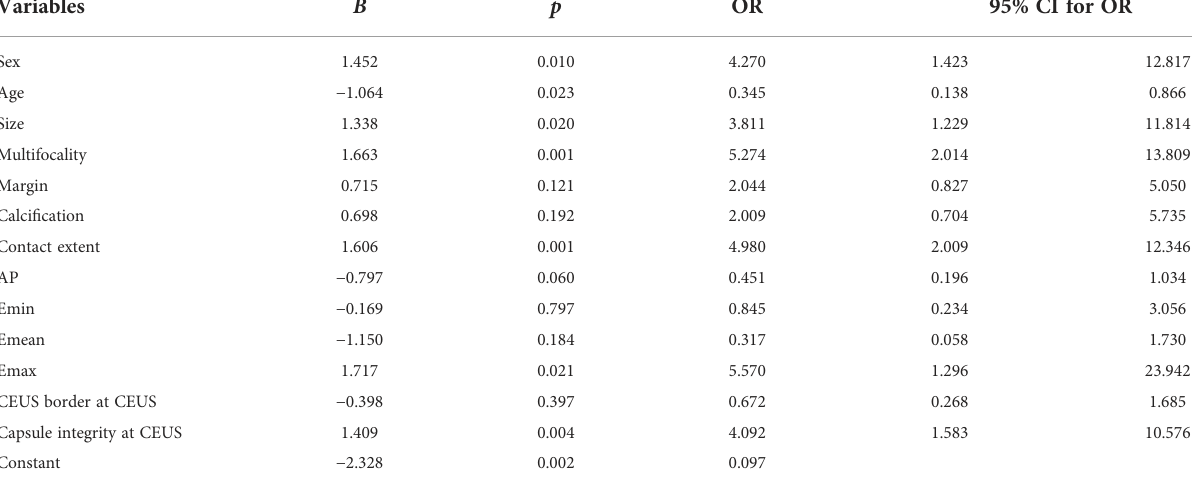
TABLE 3 Multivariate logistic regression analysis of clinical data, conventional ultrasound, AP, SWE, and CEUS.